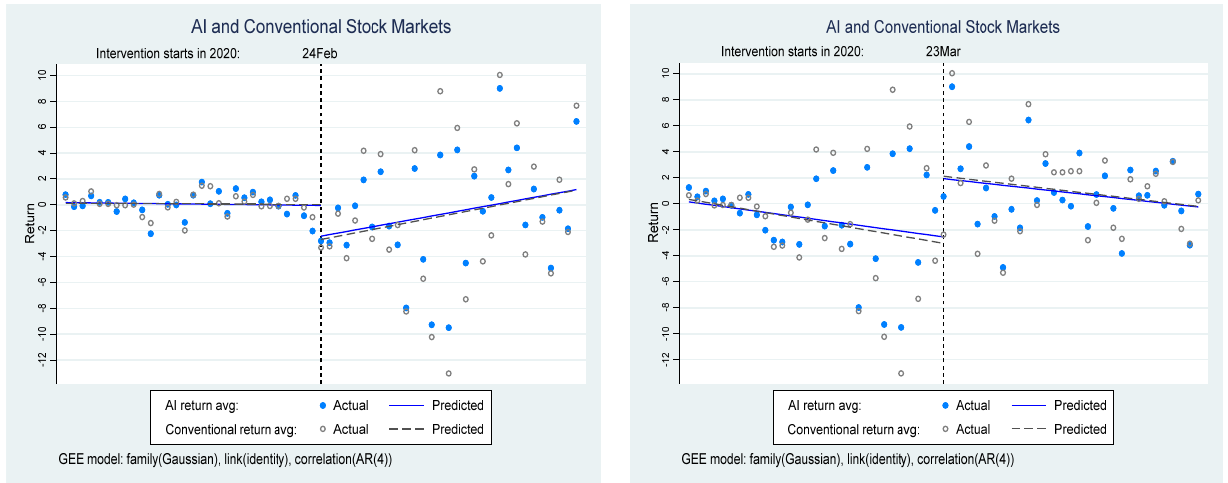
Figure 4. Single impact of COVID-19 on artificial intelligence and conventional stock markets. ( a